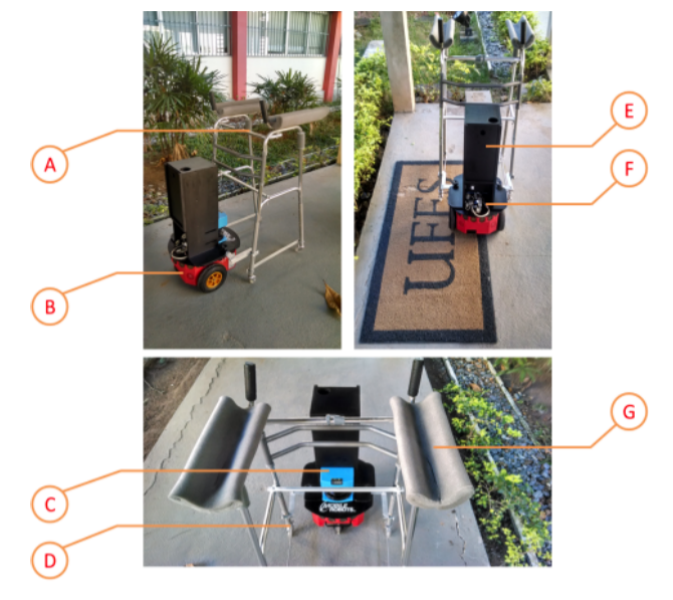
Figure 3. Diagram showing the structures that compose our smart walker